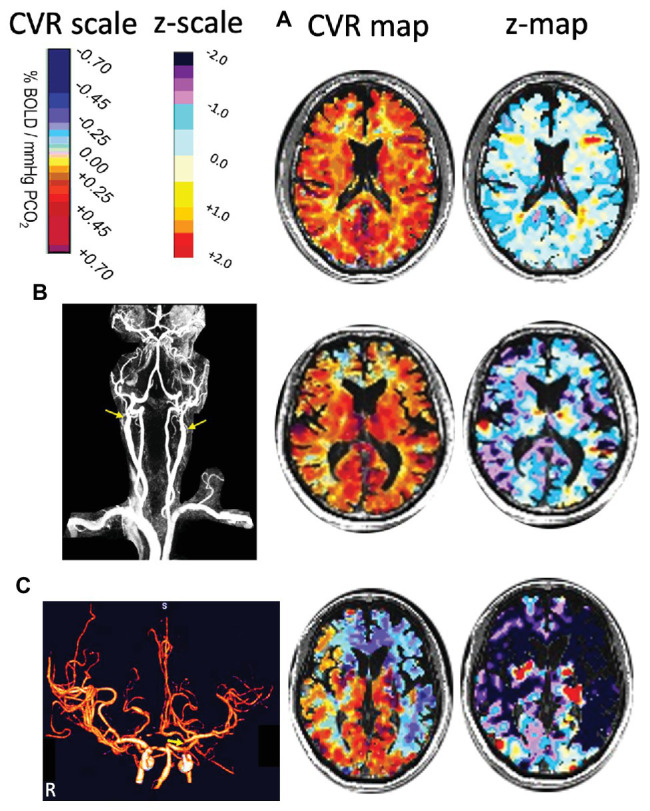
Three cases illustrating how z-maps display abnormality not readily distinguished from CVR maps. (A) A healthy 65-year old control subject. The CVR and z-maps of a representative axial slice show that the distribution of z scores are around 0 within a range of ±1 SD. (B) A 76-year-old man with bilateral proximal internal carotid artery (ICA) occlusions (as shown by arrows in MRA) and normal neurological examination. The CVR and z-maps of a representative axial slice show that the spatial distribution of CVR values was restricted to the lower normal range compared to the CVR z-map in A. (C) A 59-year-old man with transient ischemic attacks but no MRI evidence of ischemic injury. CT angiography shows distal left ICA near occlusion (arrow) and less than 50% proximal right ICA stenosis (not shown). The CVR and z-maps of a representative axial slice show steal (blue CVR) in the RACA, LACA, and LMCA territories. Note the absent right A1 segment of the RACA accounting for steal caused by the distal LICA stenosis, with the z-map measuring the severity and extent of vascular abnormality. CT, computed tomography; CVR, cerebrovascular reactivity; LACA, left anterior cerebral artery; LICA, left internal carotid artery; LMCA, left middle cerebral artery; MRA, magnetic resonance angiography; RACA, right anterior cerebral artery.